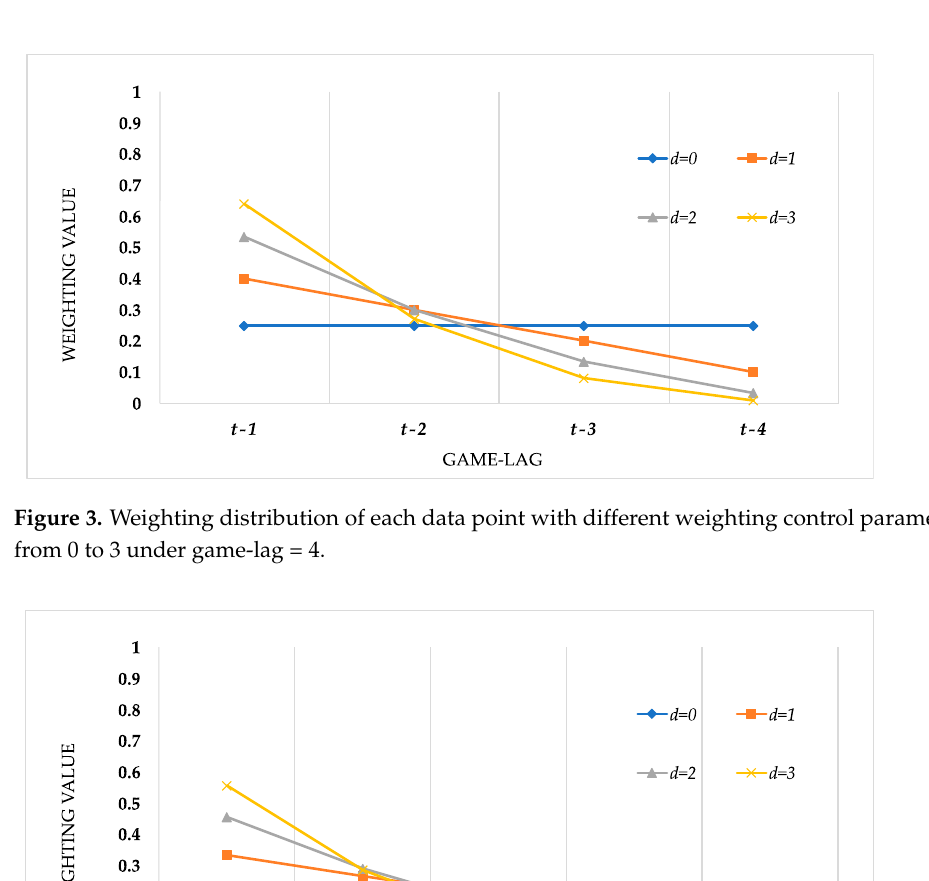
Figure 2. Weighting distribution of each data point with different weighting control parameter ( d ) from 0 to 3 under game-lag = 3.